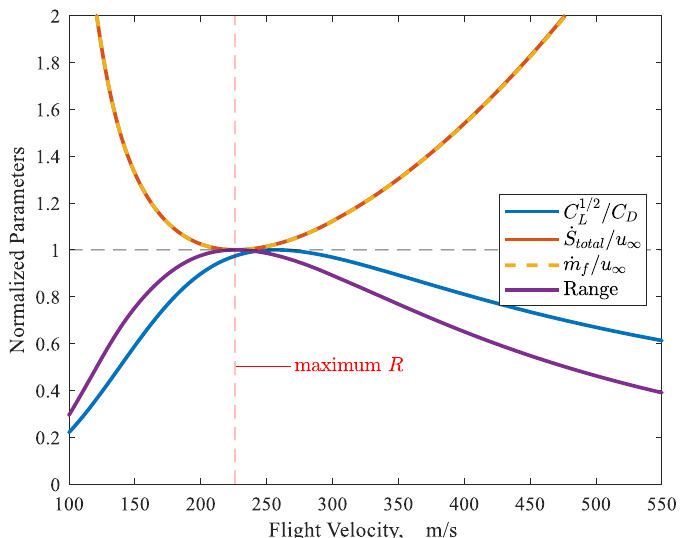
Figure 8. Normalized range related parameters over range of flight velocities. F-5E airframe with modelled turbojet engines. Altitude = 9 km.